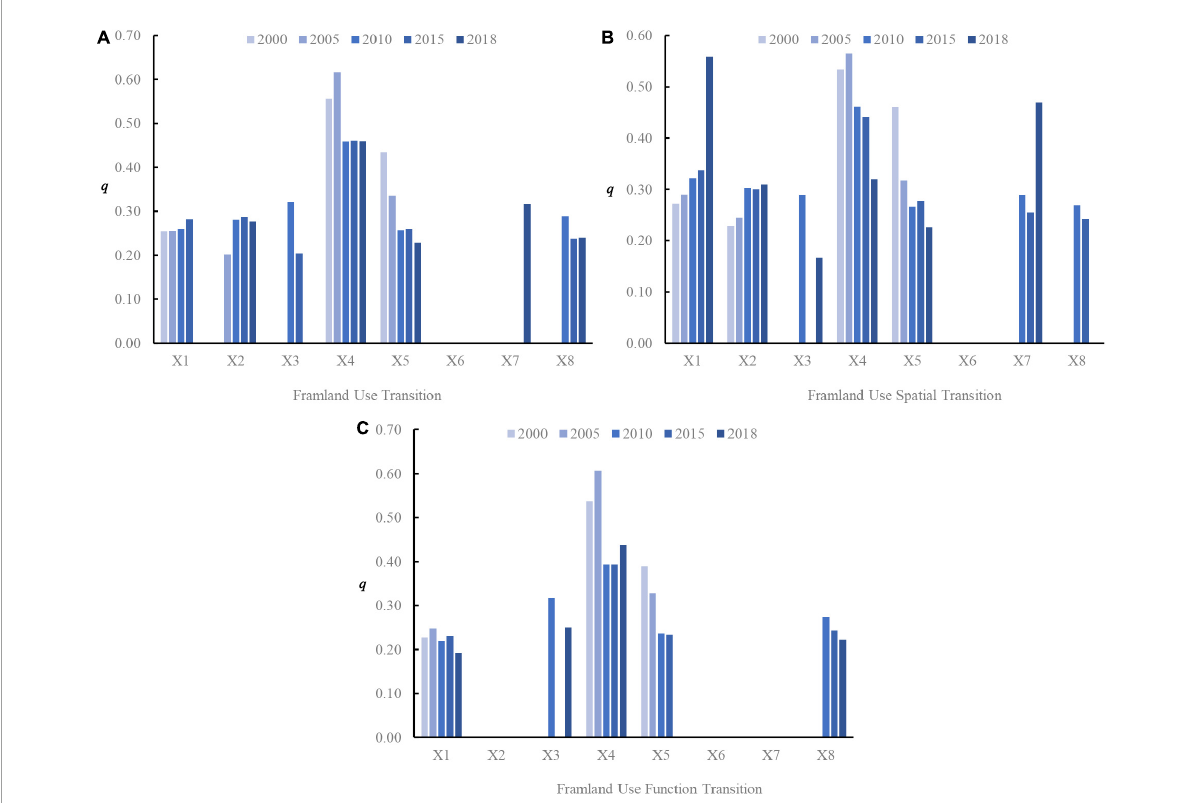
FIGURE7 Factor detection results of (A) farmland use transition, (B) farmland use spatial transition, and (C) farmland use function